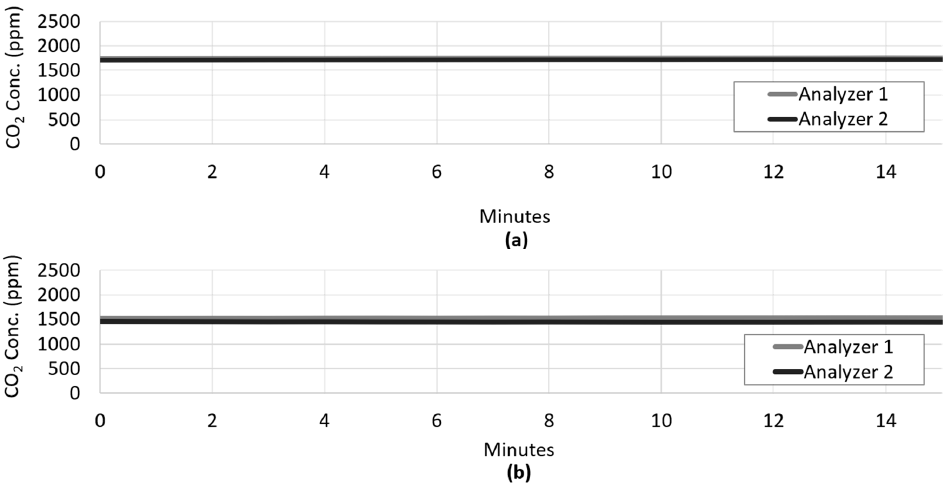
Figure 6. Abiotic control tests were performed in which concentrated CO 2 was channeled through the uninoculated system for 0.25 h at a flow rate of 20 mL/min ( a ), and 2.5 mL/min ( b ). In both cases, the influent and effluent CO 2 concentration remained virtually unchanged, demonstrating that without assimilation by the photoautotrophic biofilm, CO 2 loss was minimal.